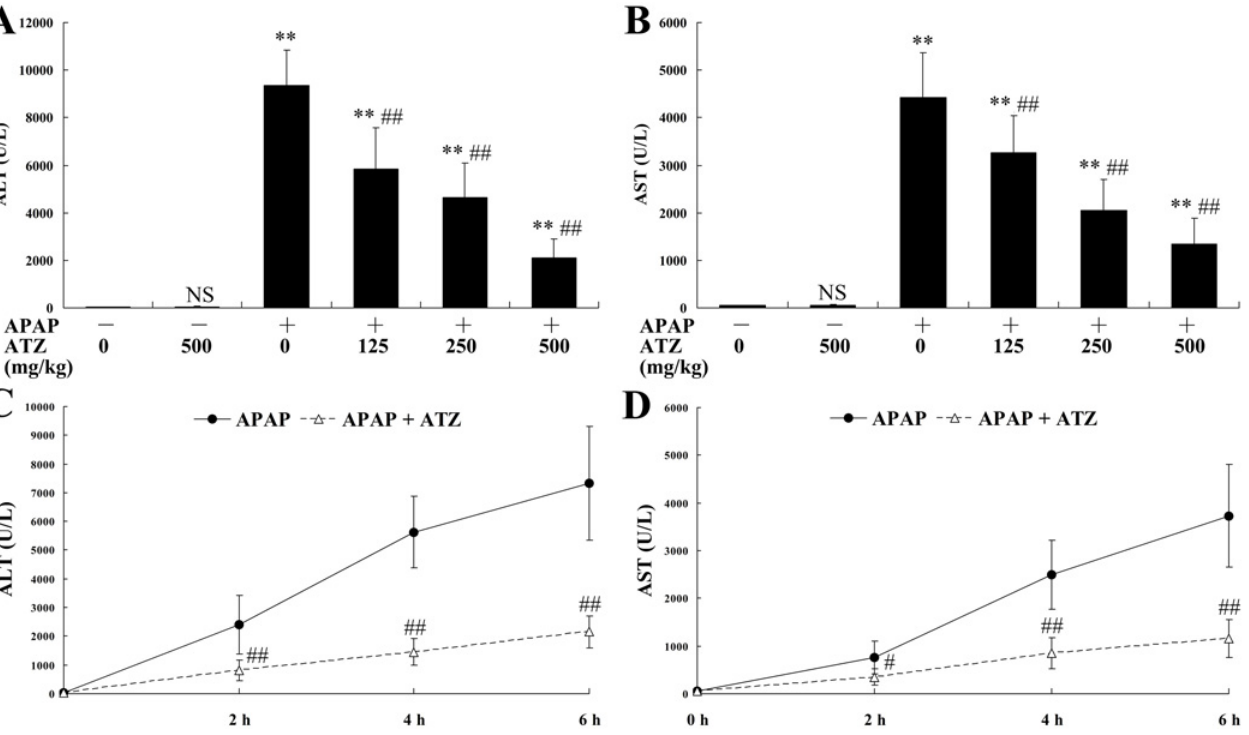
Fig 1. Pretreatment with ATZ suppressed the elevation of plasma aminotransferases induced by APAP. Mice were pretreated with vehicle or indicated doses of ATZ before APAP exposure. The plasma levels of alanine aminotransferase (ALT, A) and aspartate aminotransferase (AST, B) were determined at 8 h after APAP exposure. Data were expressed as mean ± SD, n = 8. * P < 0.05, ** P < 0.01, as compared with APAP group (APAP +/ATZ 0). In another set of animals, the mice were treated with either vehicle or ATZ (500 mg/kg) before APAP exposure. The mice were sacrificed at 2 h, 4 h or 6 h after APAP exposure and the plasma levels of ALT (C) and AST (D) were determined. The data were expressed as the mean ± SD, n = 8. NS P > 0.05, ** P < 0.01, as compared with the CON group; # P < 0.05, ## P < 0.01, as compared with the APAP group.